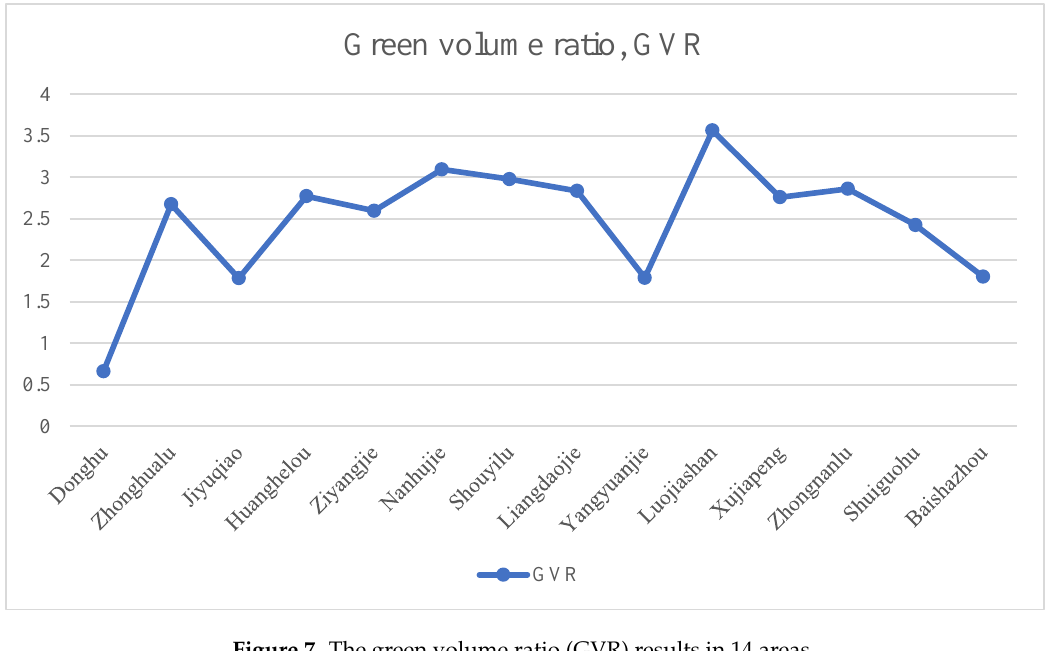
Figure 7. The green volume ratio (GVR) results in 14 areas.